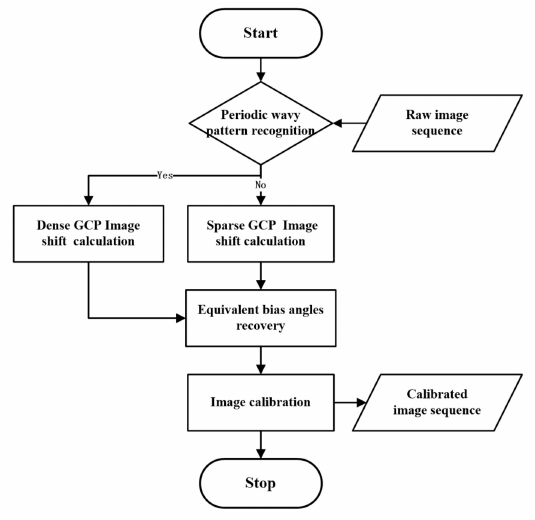
Figure 2. Flowchart of the proposed